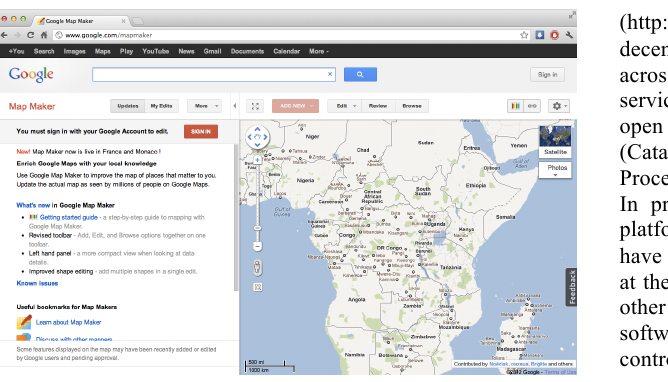
Figure 6. Google Map Maker